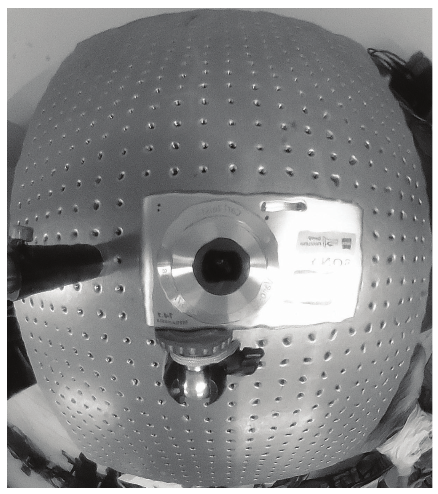
Figure 6: The catadioptric system mounted over a calibration